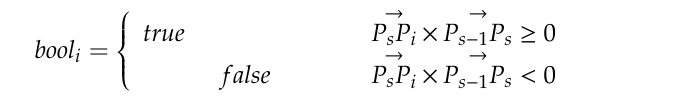
Table 1. Seedling defect characterization.